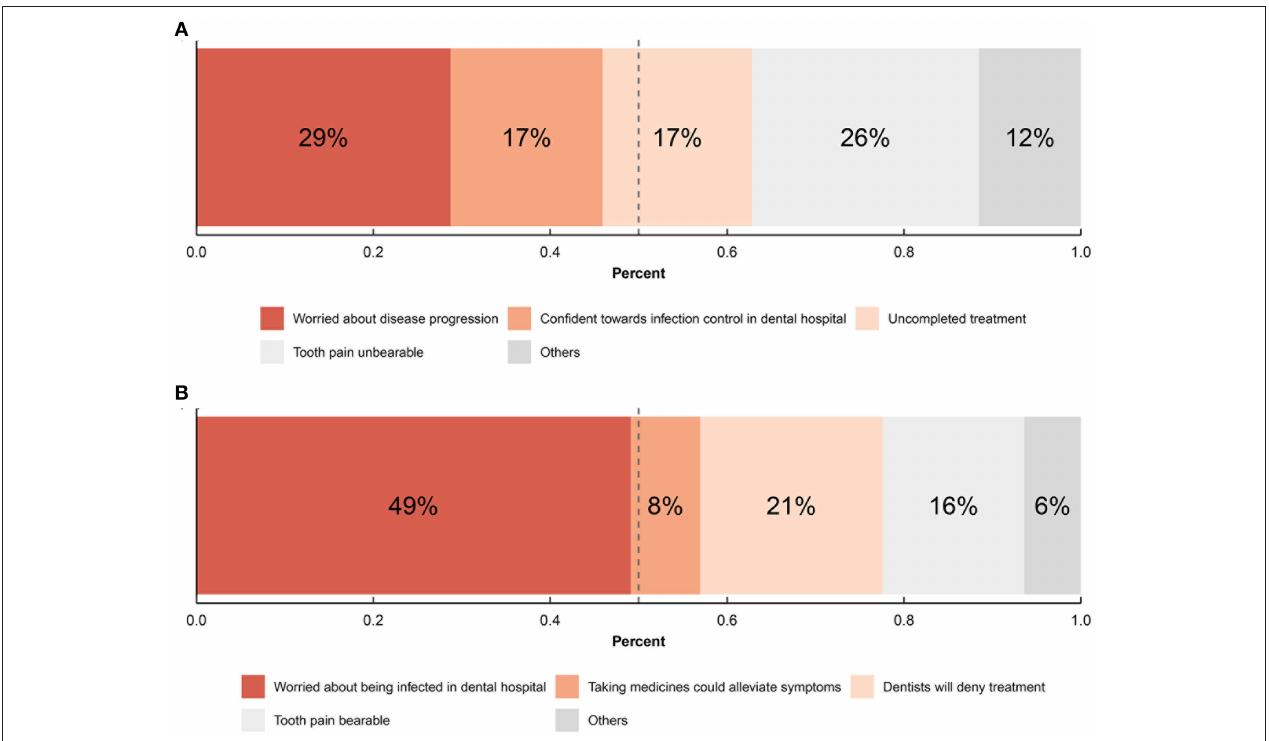
FIGURE 1 | Distributions of reasons for dental attendance and avoidance. (A) Distribution of reasons of dental attendance among respondents who visited dentists; (B) distribution of reasons of dental avoidance among respondents who did not visit